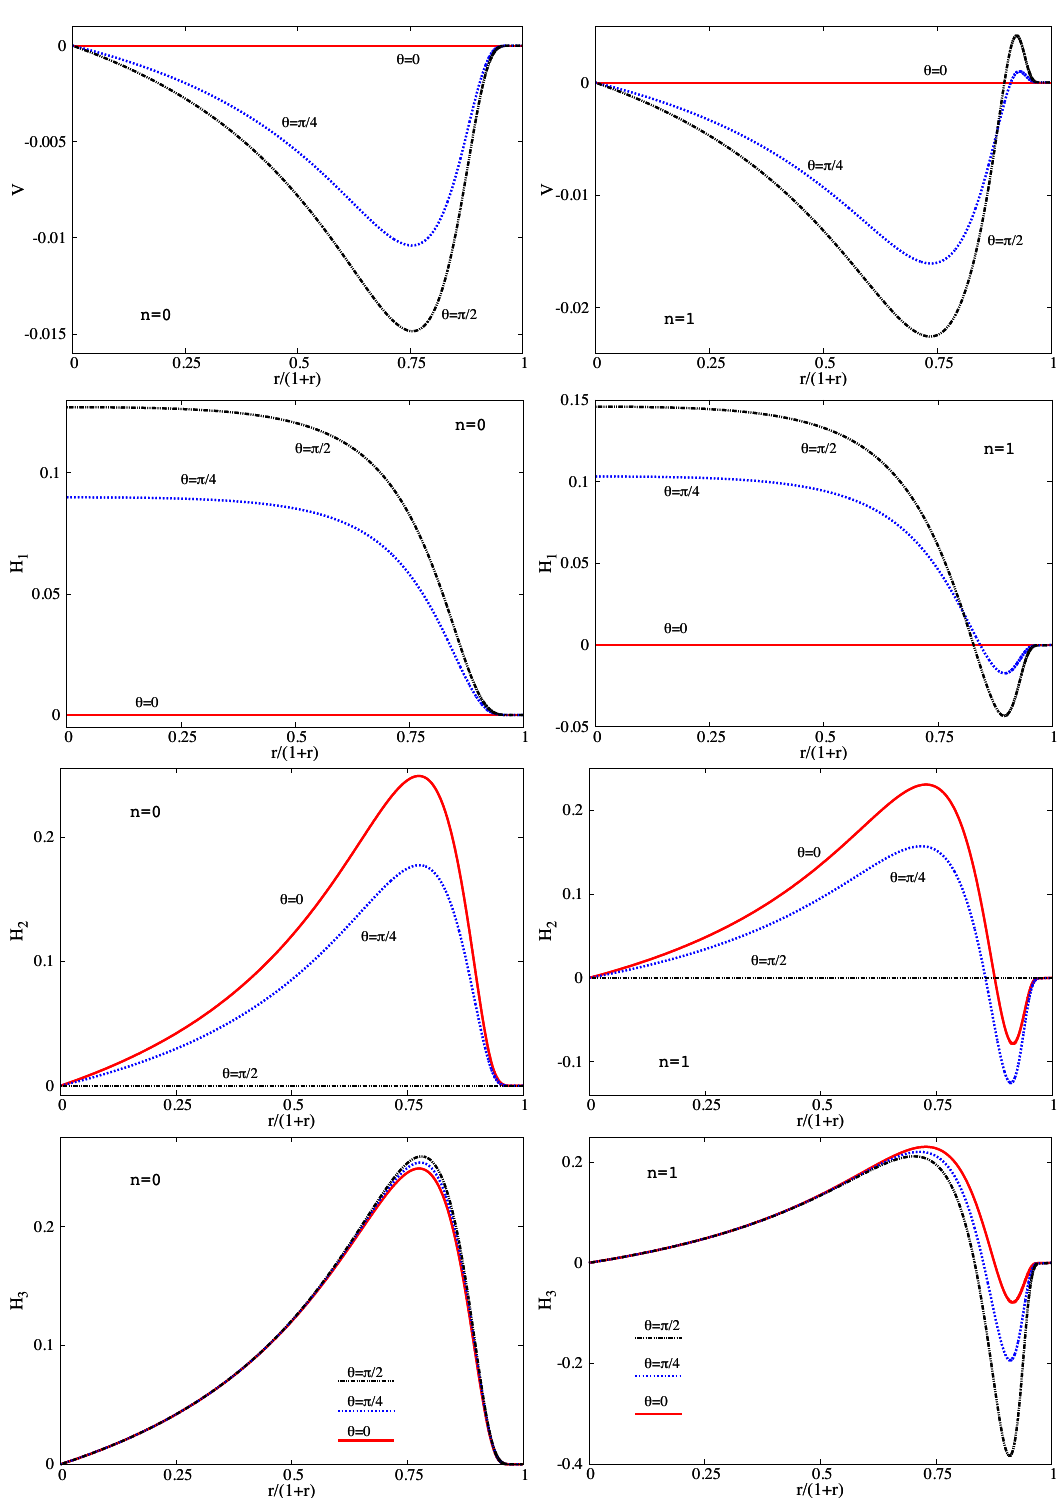
Figure 7 . Same as in (cid:12)gure 6, but for the Proca potential functions.